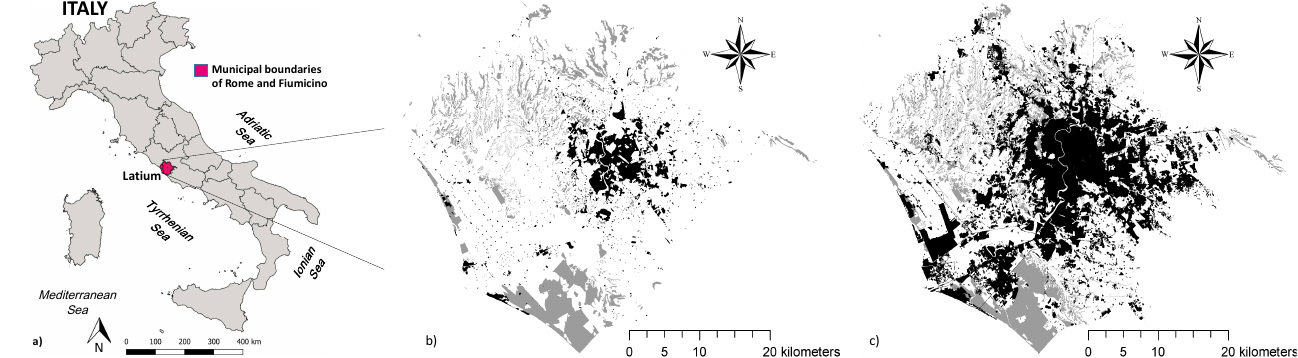
Figure 1. A map indicating the position of the study area (Rome and Fiumicino municipality) in Central Italy ( a ) and two maps illustrating the spatial distribution of basic land-use classes (black: urban settlements; grey: woodlands; and white: agricultural areas) in Rome 1949 ( b ); 2016 ( c ). Urban settlements include impervious land and urban parks; agricultural areas include arable land, crop mosaic, vineyards, and olive groves; and woodlands include forests, pastures, and water bodies.